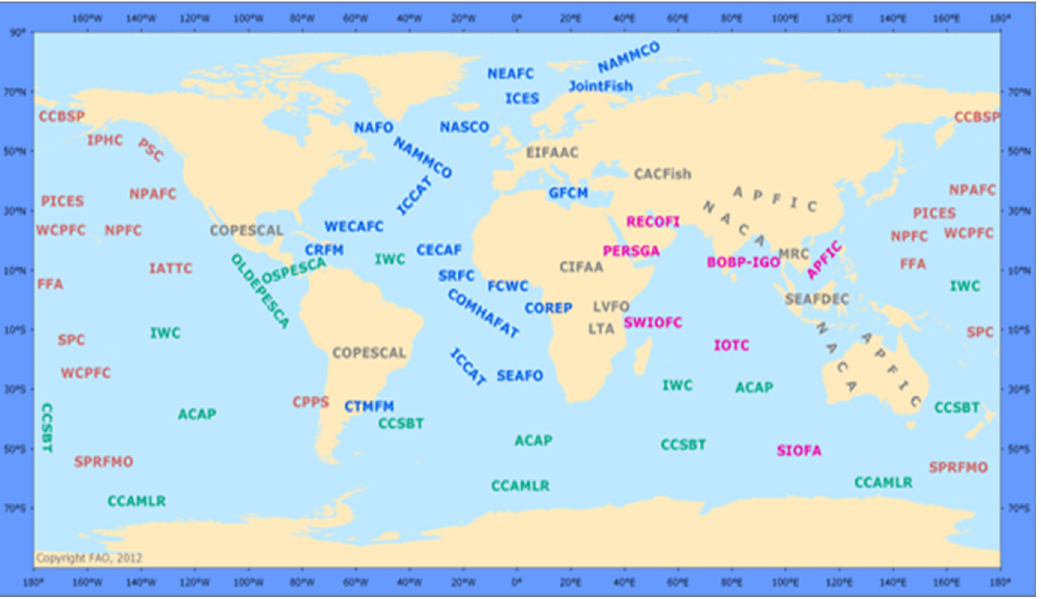
Figure 1. Illustrative Map of the Regional Fisheries Bodies. Reproduced from [19], with permission from Food and Agriculture Organization of the United Nations, 2022.